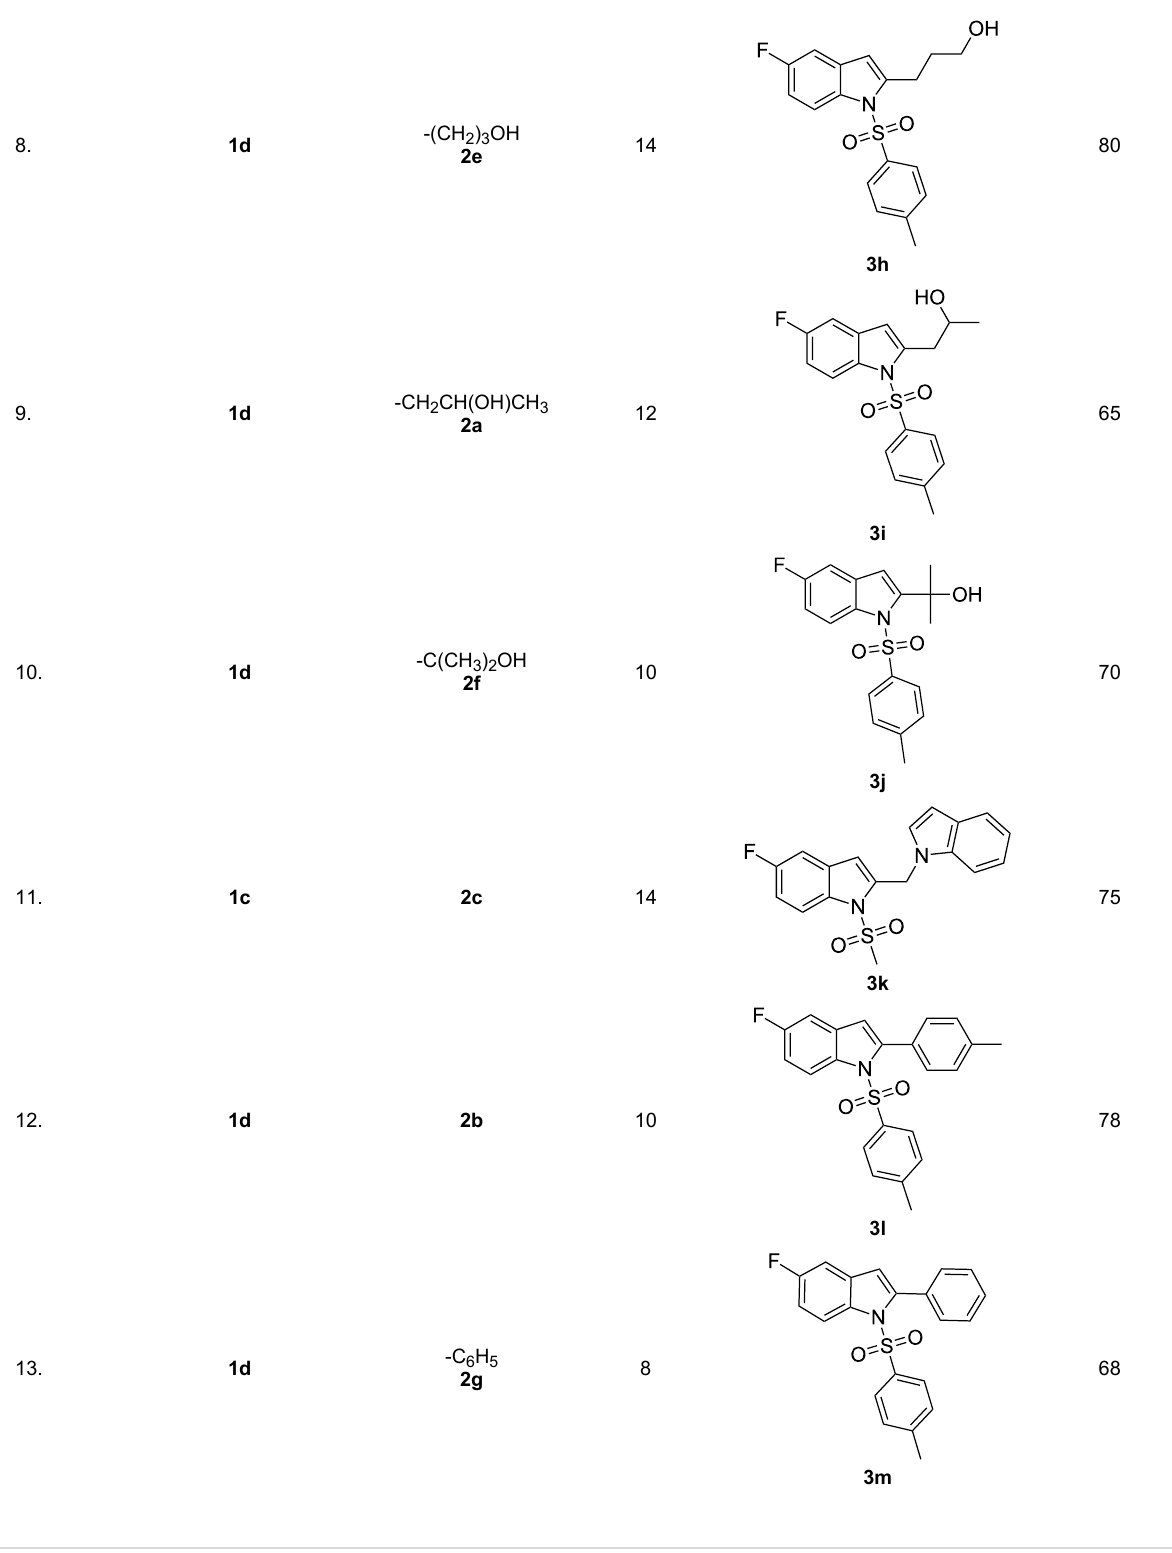
Table 1: Pd/C-Catalyzed synthesis of 2,5-disubstituted N -sulfonyl-indoles in aqueous media. a (continued)